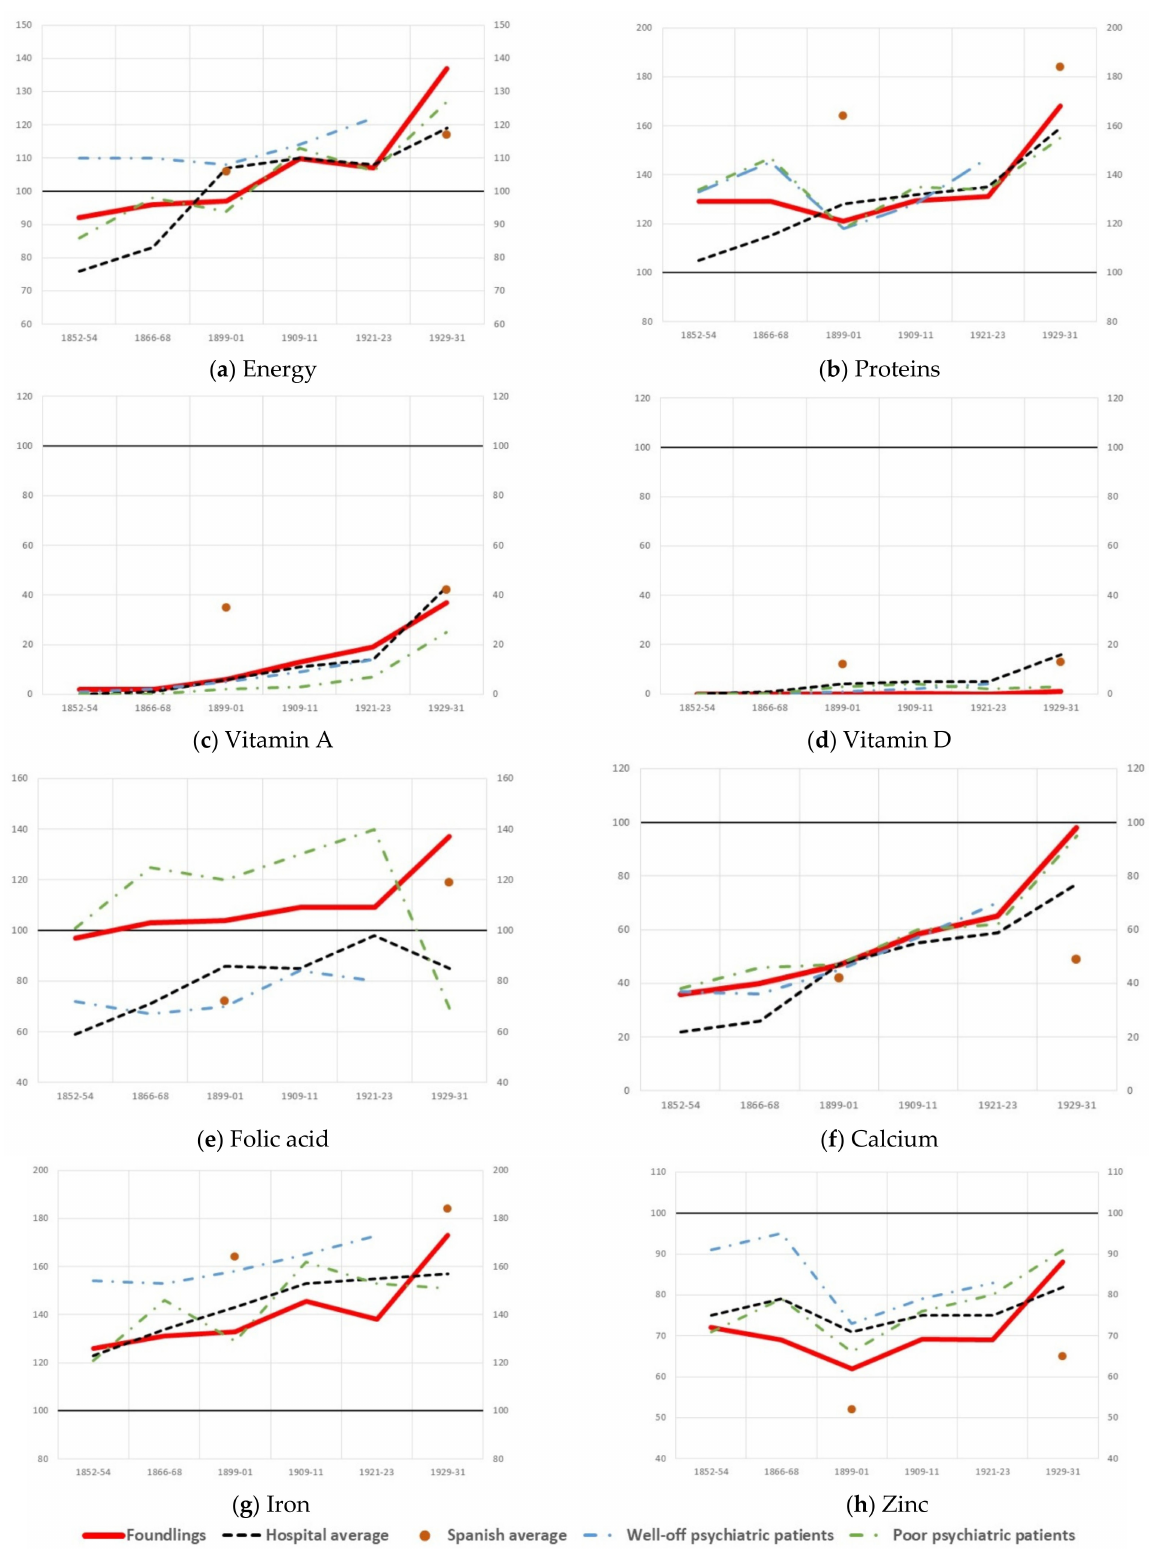
Figure 2. Contribution of energy and nutrients with respect to the Recommended Dietary Allowances (RDA = 100) in the average daily diet of foundlings and other population groups in the Hospital General de Valencia, 1852–1931. Source: